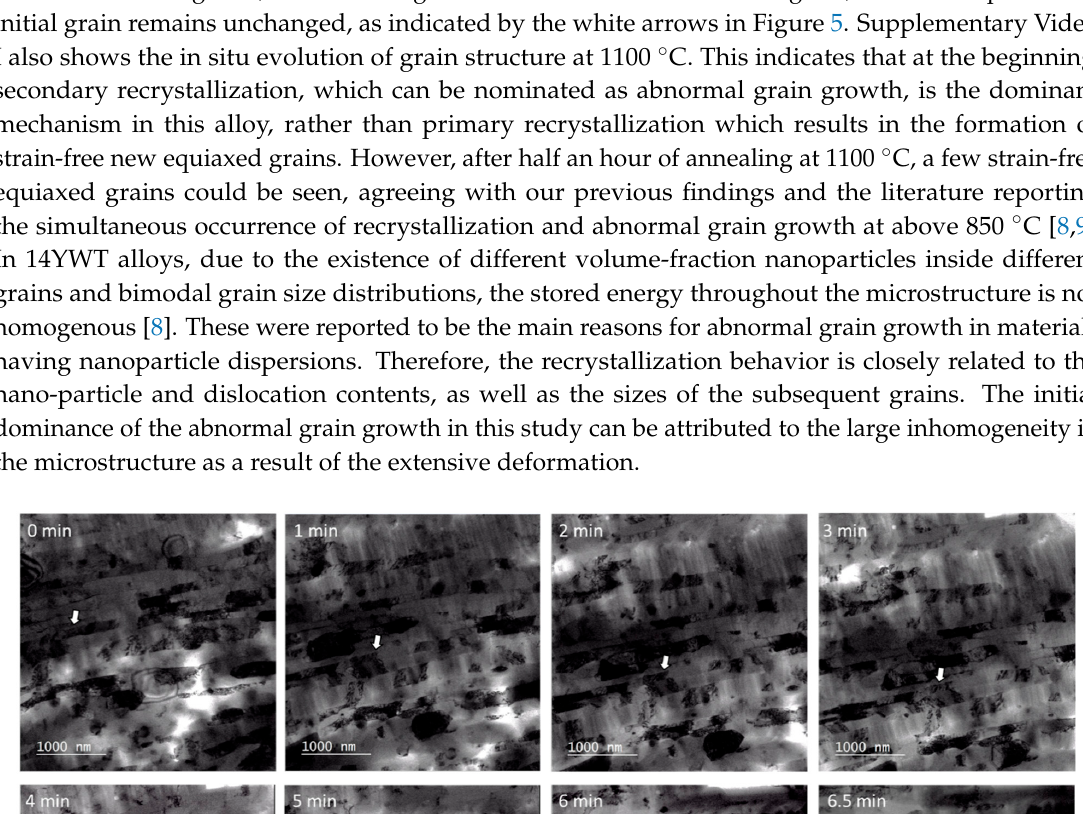
h.; Figure S2: The gray scale, orientation and KAM maps of 14YWT alloys after (a) 0.5 h (b) 1 h (c) 2 h (d) 3 h and (e) 4 h of annealing at 1100 °C. Scales of all the micrographs are the same.